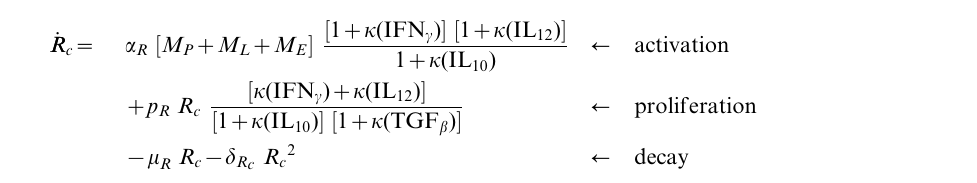
N Humoral response: R h represents the type 2 T helper cells, the B lymphocytes and the antibodies. Activation is amplified by IL 10 and inhibited by IFN c and IL 12 ; proliferation is activated by IL 10 and inhibited by IFN c , IL 12 and TGF b (4b in Figure 1). R h synthesises IL 10 (5b in Figure 1) and neutralises free viral particles through antibodies (6 in Figure 1). N Regulatory response: R r represents the regulatory T cells.